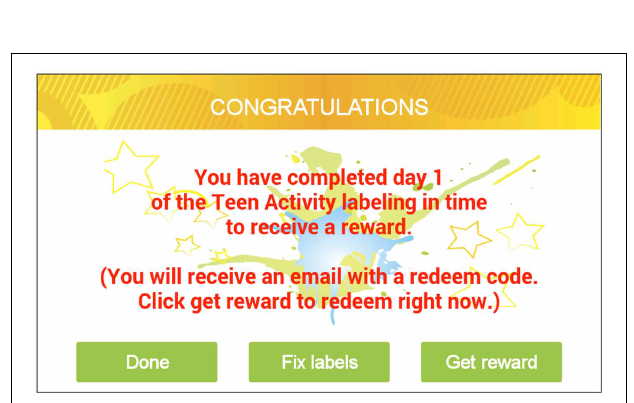
FIGURE 7 | Screenshot of the reward redemption at the end of the sensor-assisted end-of-day recall component